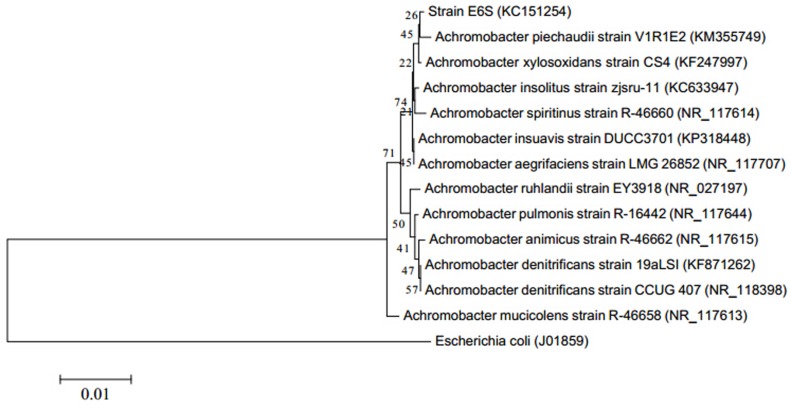
Phylogenetic tree showing the relationship of partial 16S rDNA gene sequences from endophytic bacterium E6S homologous to Achromobacter piechaudii with other related sequences from Achromobacter.
Escherichia coli was used as the out-group. The value on each branch is the percentage of bootstrap replications supporting the branch.